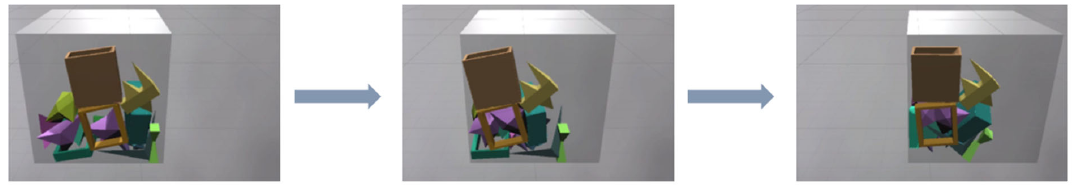
Fig. 1. Translation in the x-axis using the instance SGPS04nc20a